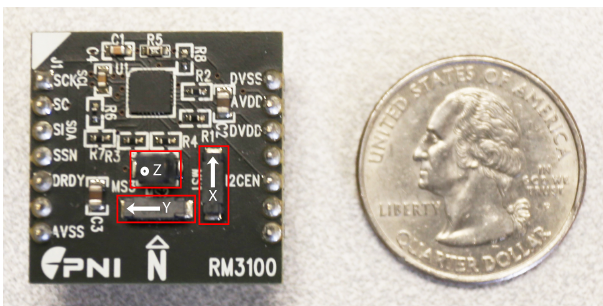
Figure 1. PNI RM3100 magnetometer shown next to a US quarter coin for size comparison. The red rectangles show the location of the sensing coils.